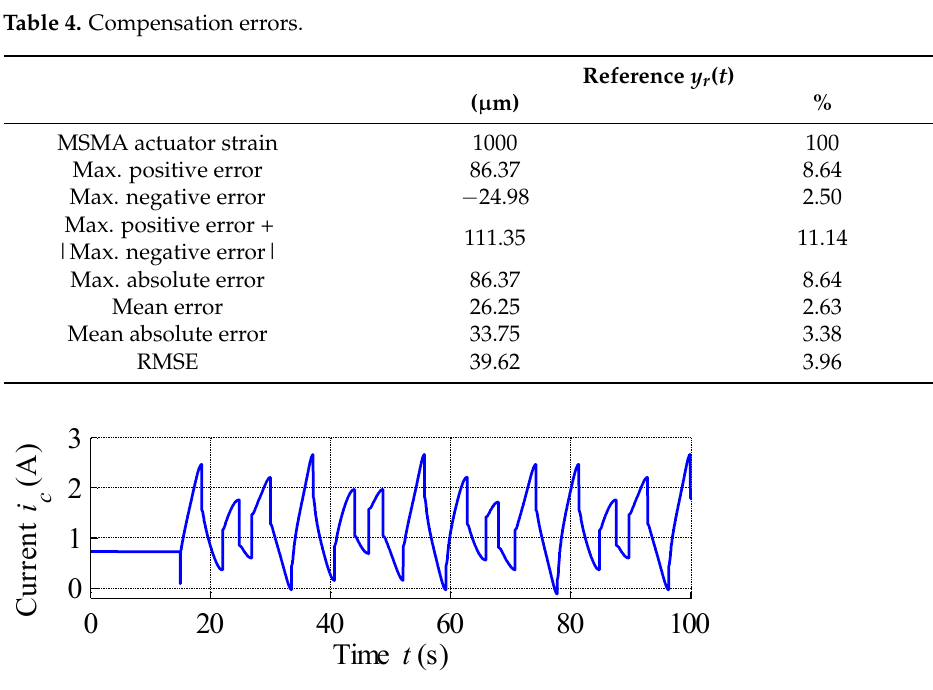
Figure 20. Nonlinear current control signal.